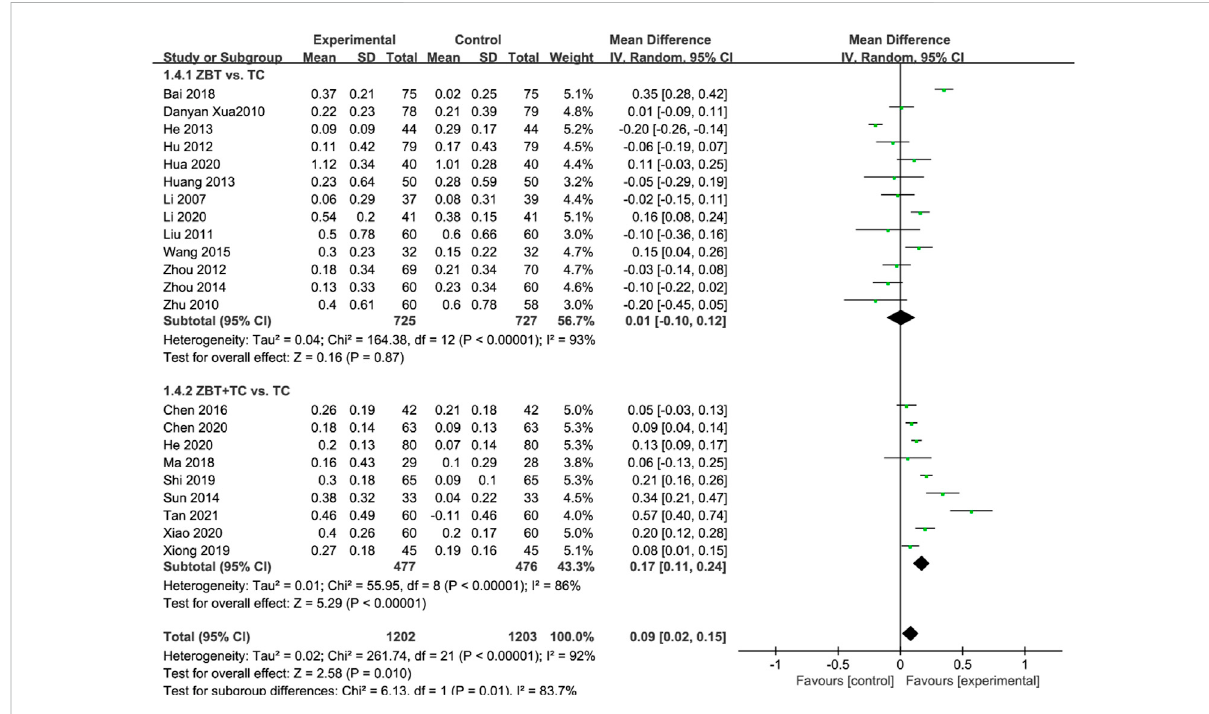
FIGURE 6 Meta-analysis results of the effect of Zhibitai (ZBT) vs. conventional therapy (CT) on high-density lipoprotein cholesterol (HDL-C).